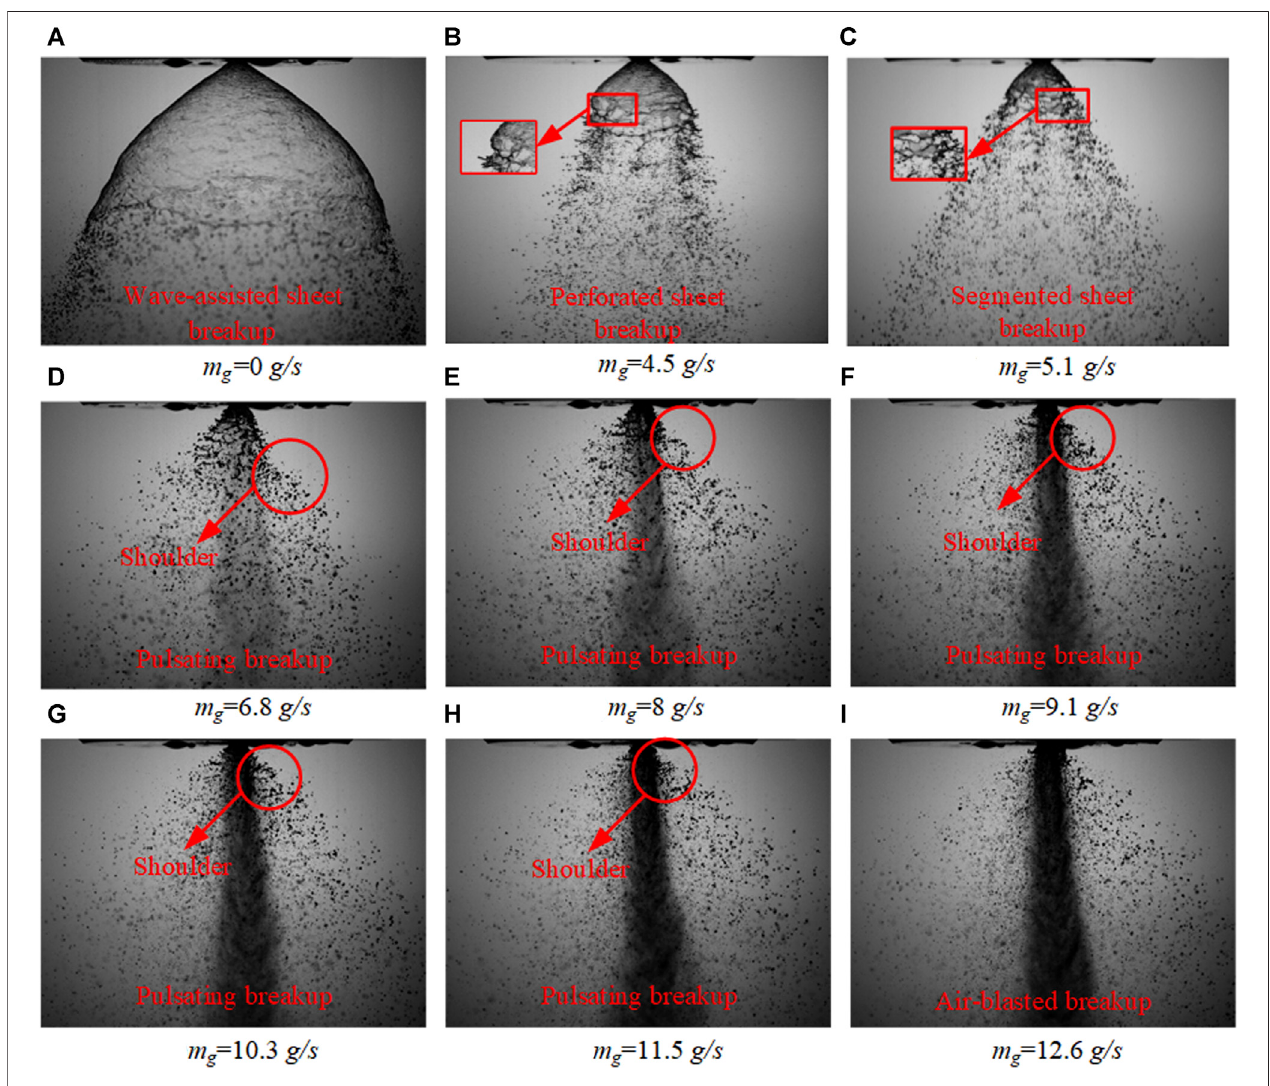
FIGURE 10 | Effect of gas-liquid ratio on